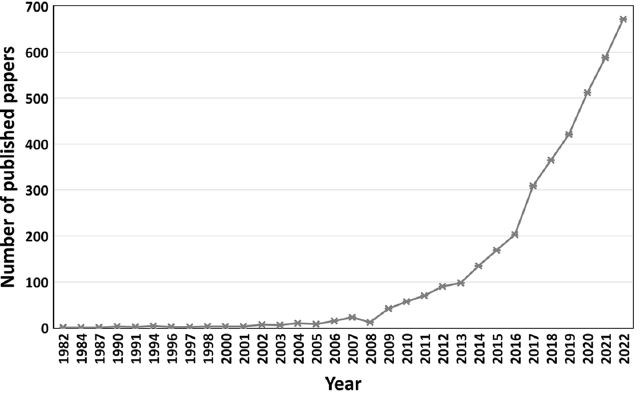
Figure 3. Overview of previous published papers for residential thermal comfort studies.